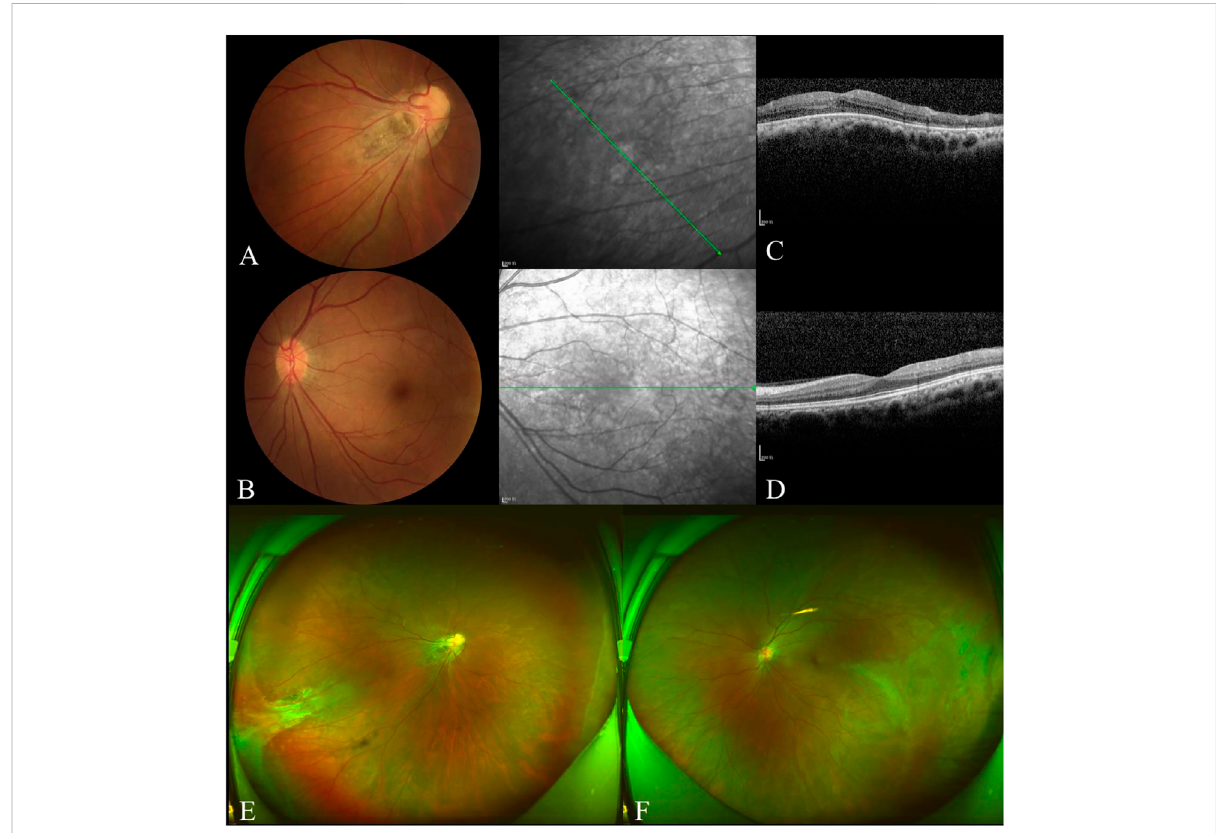
FIGURE 4 Examination results of the proband ’ s father. The boundary of the optic disc in the right eye was unclear, and the color was slightly pale (A) . The retinal blood vessels were pulled to the temporal side on the right and slightly on the left (B) . OCT showed persistent inner foveal retinal layers and diminished foveal contour with IS/OS thinned and discontinuous in the right (C) . The structures of the central fovea of the left eye were normal (D) . The peripheral retinal blood vessels were fl at and numerous in both eyes, accompanied by fi ber proliferation and traction, presented as ‘ sickle fold ’ in the right (E) . The peripheral retinal vessels are straight and numerous, accompanied by avascular areas that showed ‘ inverted V ’ (F) .